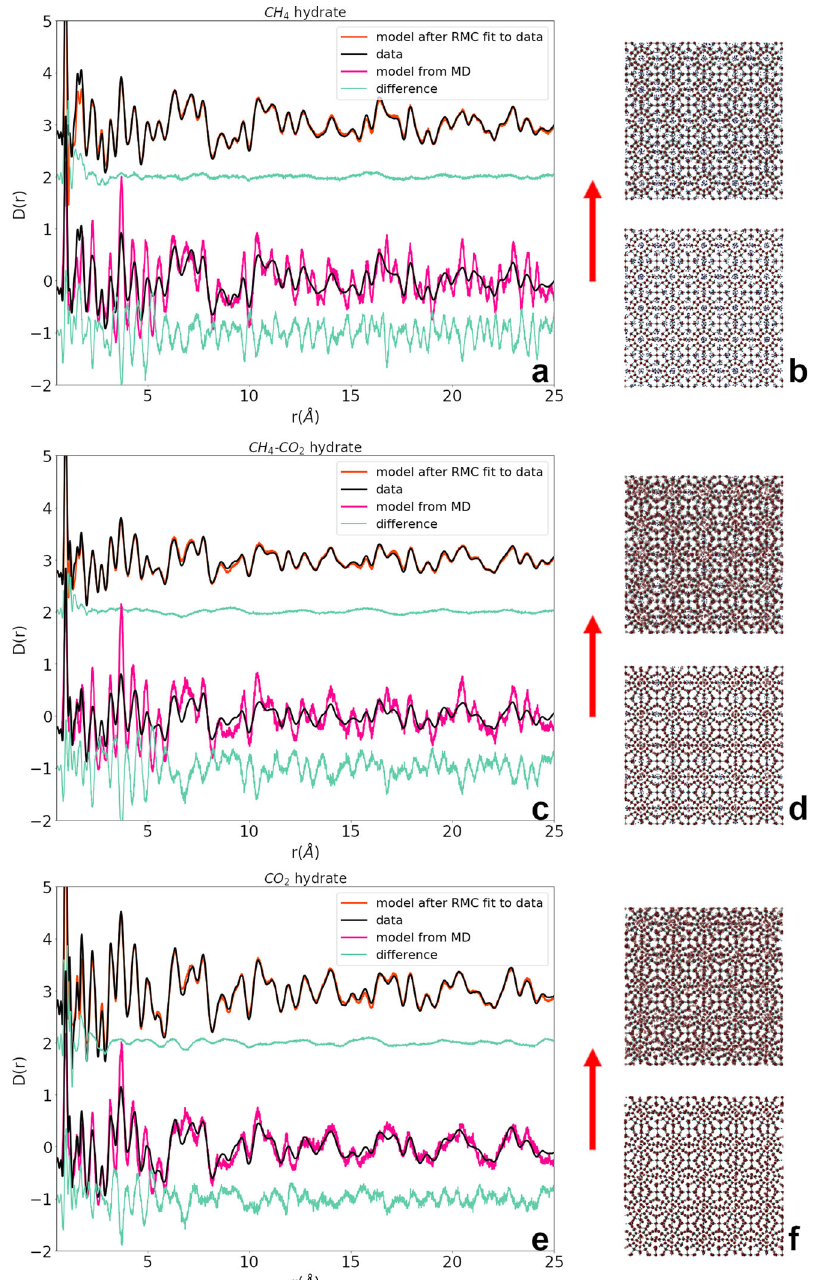
Fig. 1 Neutron PDF data and models. Comparison of experimental neutron PDF data with MD modeled PDF ( a , c , e bottom spectra) and the model fi t to the data with RMC ( a , c , e top spectra) with corresponding difference patterns for CH 4 ( a ), CH 4 – CO 2 ( c ), and CO 2 ( e ) hydrates. The overall disorder that RMC models ( b , d , f top) calculate is also evident when compared with the MD structures ( b , d , f